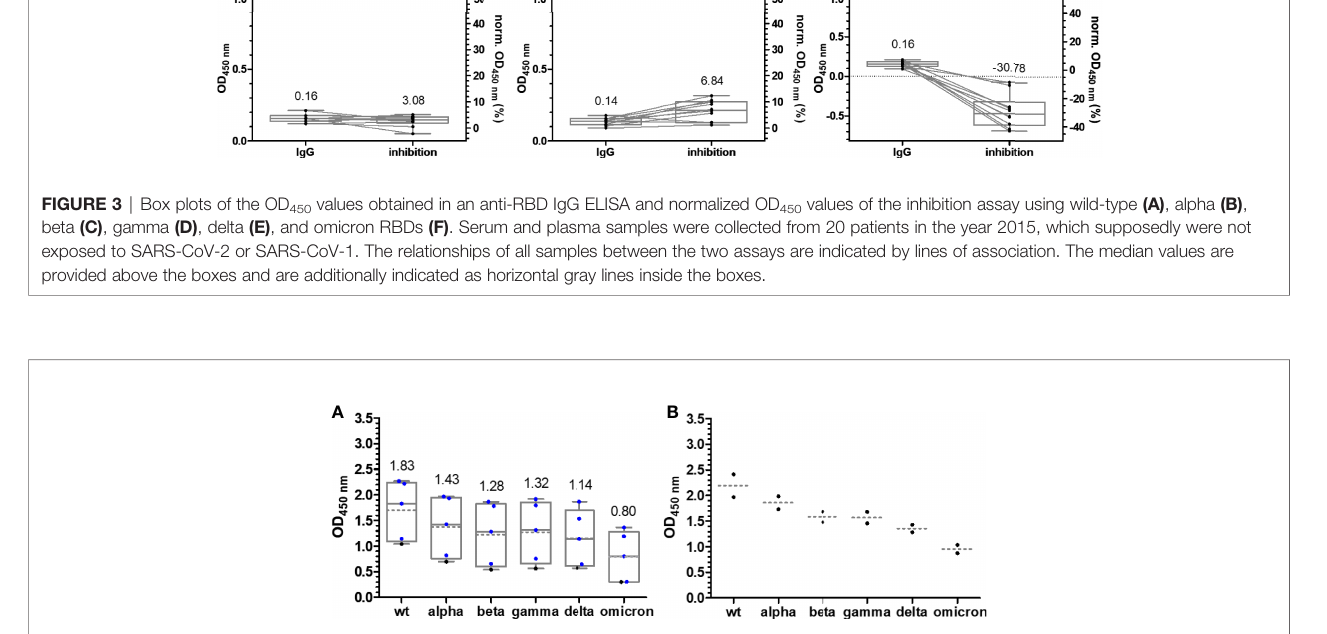
FIGURE 4 | Box plots of the OD 450 values obtained in an anti-RBD IgG ELISA for people vaccinated with mRNA-1273 (A) and BNT162b2 (B) around 2 weeks after the third vaccination. Serum and plasma samples were diluted 500-fold. Sera collected from people with heterologous booster vaccinations (2× mRNA-1273 and once BNT162b2) are indicated as blue dots. The median values are provided above the boxes and are additionally indicated as gray horizontal lines in the boxes, while the mean values are shown as gray horizontal dotted lines.